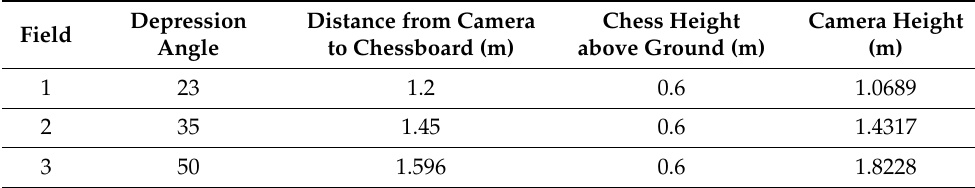
Table 10. Camera Calibration Parameters of Three